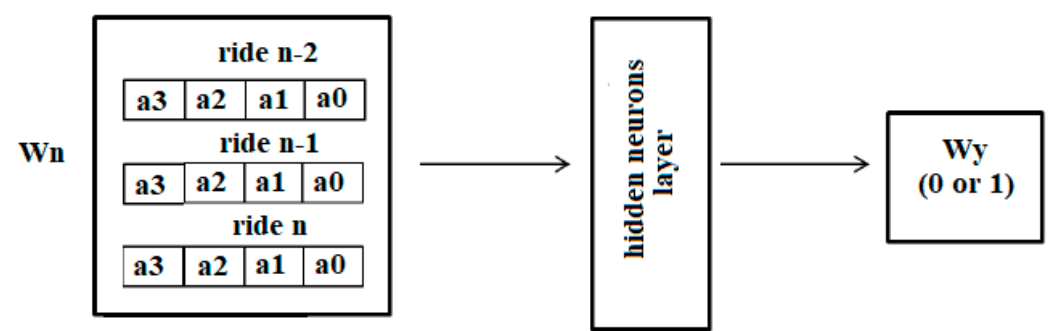
Figure 5. Diagram of a neural network using third degree polynomial coefficients for learning. a3, a2, a1, a0—polynomial coefficients characterizing specific drives, Wy—operator rating result: 0—not trained, 1—trained.